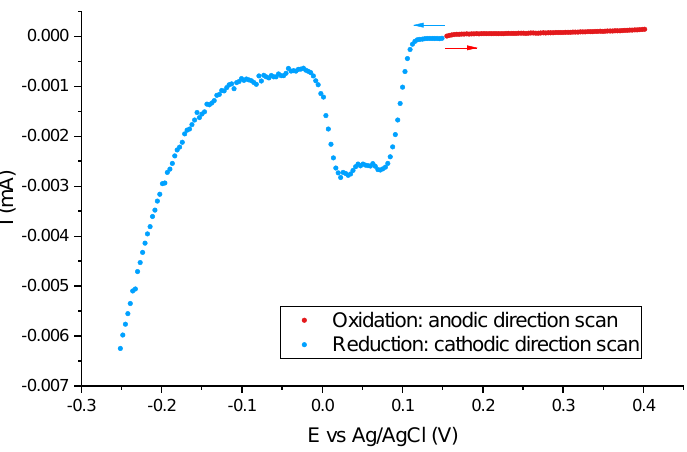
Figure 8. The test of the redox state of silver-containing molecules: linear potential scans of the SIL-prop-COOAg 9 samples in 0.1 M NaNO 3 electrolyte solution. For anodic and cathodic directions, separate samples were used. Potential scans were carried out from the neutral (zero-current) potential, equals 0.15